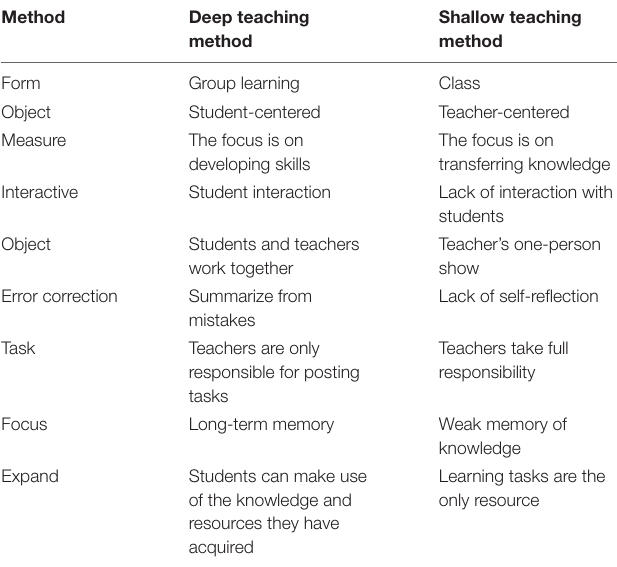
TABLE 1 | Differences between deep learning and shallow learning.